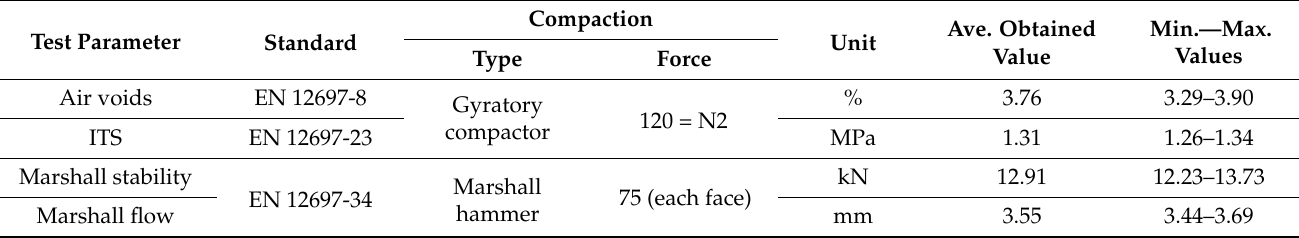
Table 4. The post-production laboratory quality control of the surface